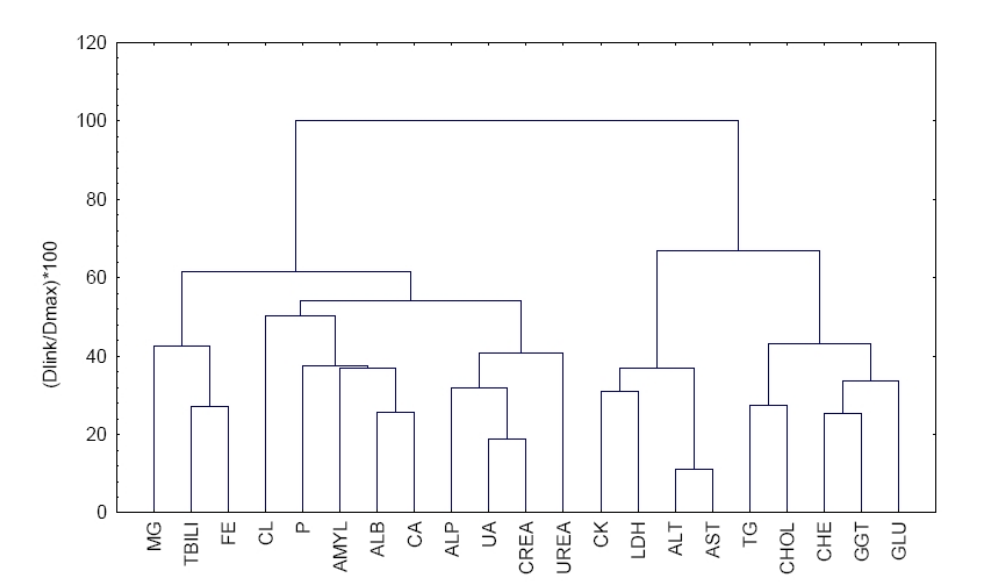
Fig. 1 Hierarchical dendrogram for 21 clinical parameters of all 185 healthy individuals.